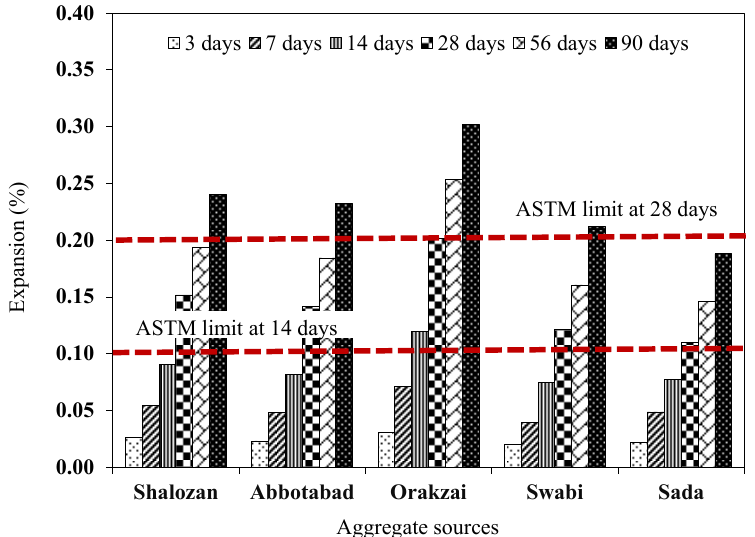
Figure 13. Expansion results of various tested aggregates.